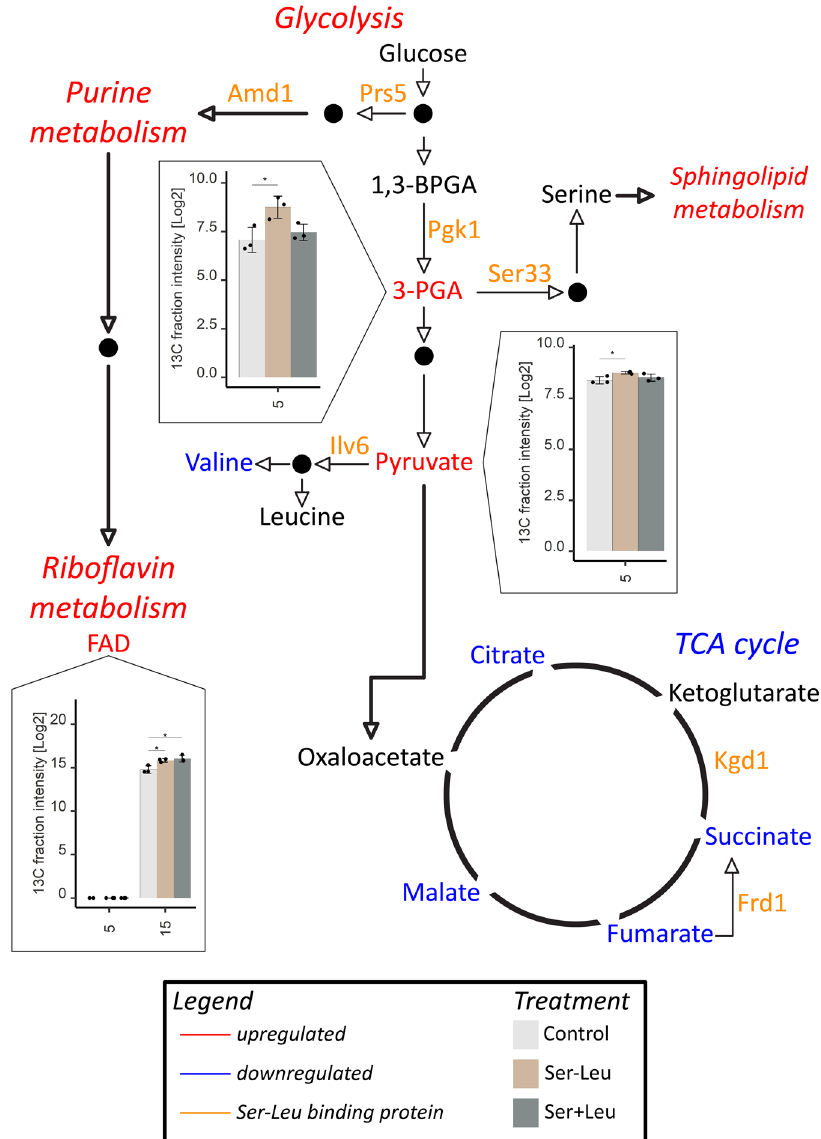
Fig. 7 YSBN2 response to Ser-Leu supplementation. Liquid chromatography- and gas chromatography-mass spectrometry analysis of metabolomic changes caused upon supplementation with 100 µ M Ser-Leu or mixture of 100 µ M serine and 100 µ M leucine (Supplementary Data S32 and S33). Presented are changes in metabolite levels (here described as total intensity) and redistribution of carbon isotope (enrichment level [%] multiplied by metabolite level, here described as 13 C fraction intensity) in yeast cells. 13 C enrichment in combination with metabolite levels provides information regarding the conversion rate of labelled substrate to the metabolite. X-axis represents time [min] upon treatment. Data represent the means ± SD, n = 3 independent samples. Asterisks denote signi fi cant difference (Tukey ’ s test, * P value < 0.05, ** P value < 0.01). Ser-Leu-binding proteins are marked orange. Level of metabolites marked red was signi fi cantly increased at least in one time-point comparing to other treatment. Level of metabolites marked blue was signi fi cantly decreased at least in one time point comparing to other treatment. Presented are cropped images (see Supplementary Figs. S14 –